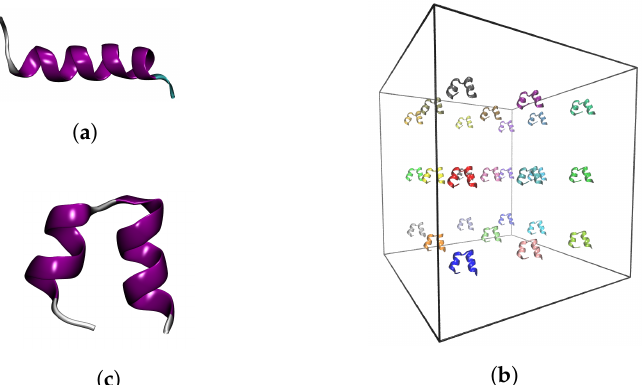
Figure 8. ( a ) Starting experimental structure of Bombinin H2. Input structures for the production simulation of: ( c ) monomeric bombinin H2; and ( b ) 27 bombinin H2 peptides in